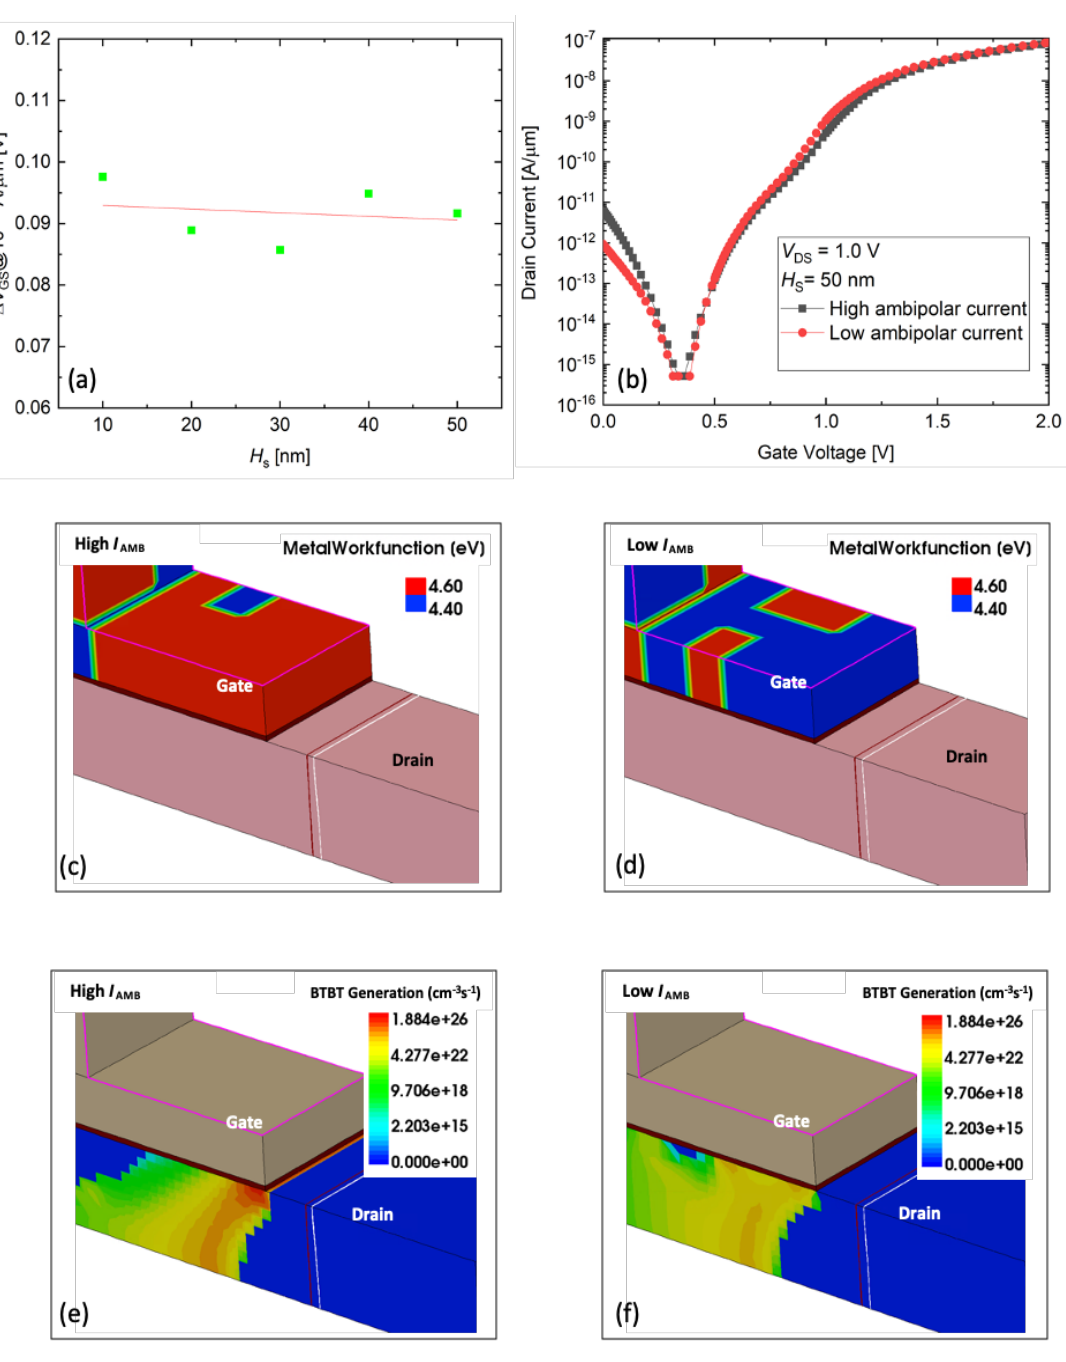
Figure 5. ( a ) I AMB variation dependency on H S . ( b ) Transfer curves with high and low I AMB . TiN-grains distribution in gate area for ( c ) high I AMB sample and ( d ) low I HUMP sample. BTBT rate for ( e ) high I HUMP sample and ( f ) low I AMB sample.